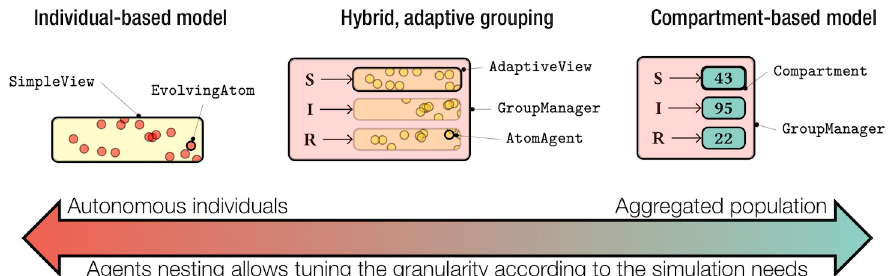
Fig 3. Diversity of modelling paradigms in EMULSION models. EMULSION allows to represent within a same formalism (nested agents) several modelling paradigms, from the finest grained (individuals) to aggregations (compartments), including intermediary representations as a trade-off between computation time and preservation of individual details. The chosen modelling paradigm is associated with the appropriate combinations of